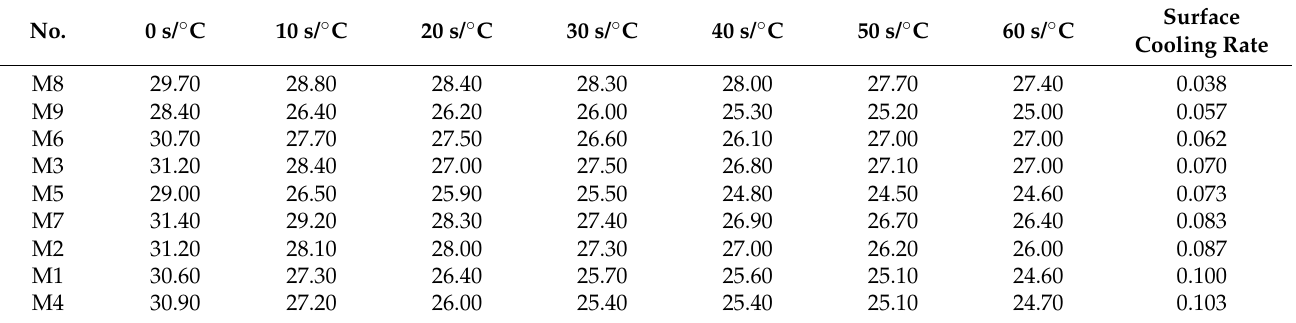
Table 3. The rate at which the surface of the cabinet material cools down (M1: Joinery board, M2: PVC board, M3: Fireproof board, M4: Solid wood board, M5: Painted solid wood board, M6: Melamine board, M7: Painted board, M8: Blister board, M9: Quartz board).